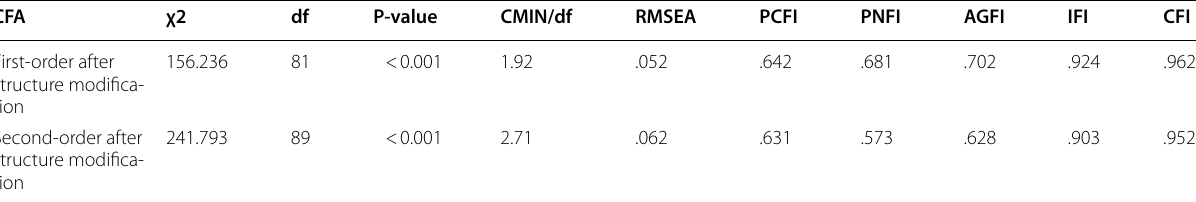
Table4 Fit indices of first- and second-order confirmatory factor analysis of the QoR-15 questionnaire